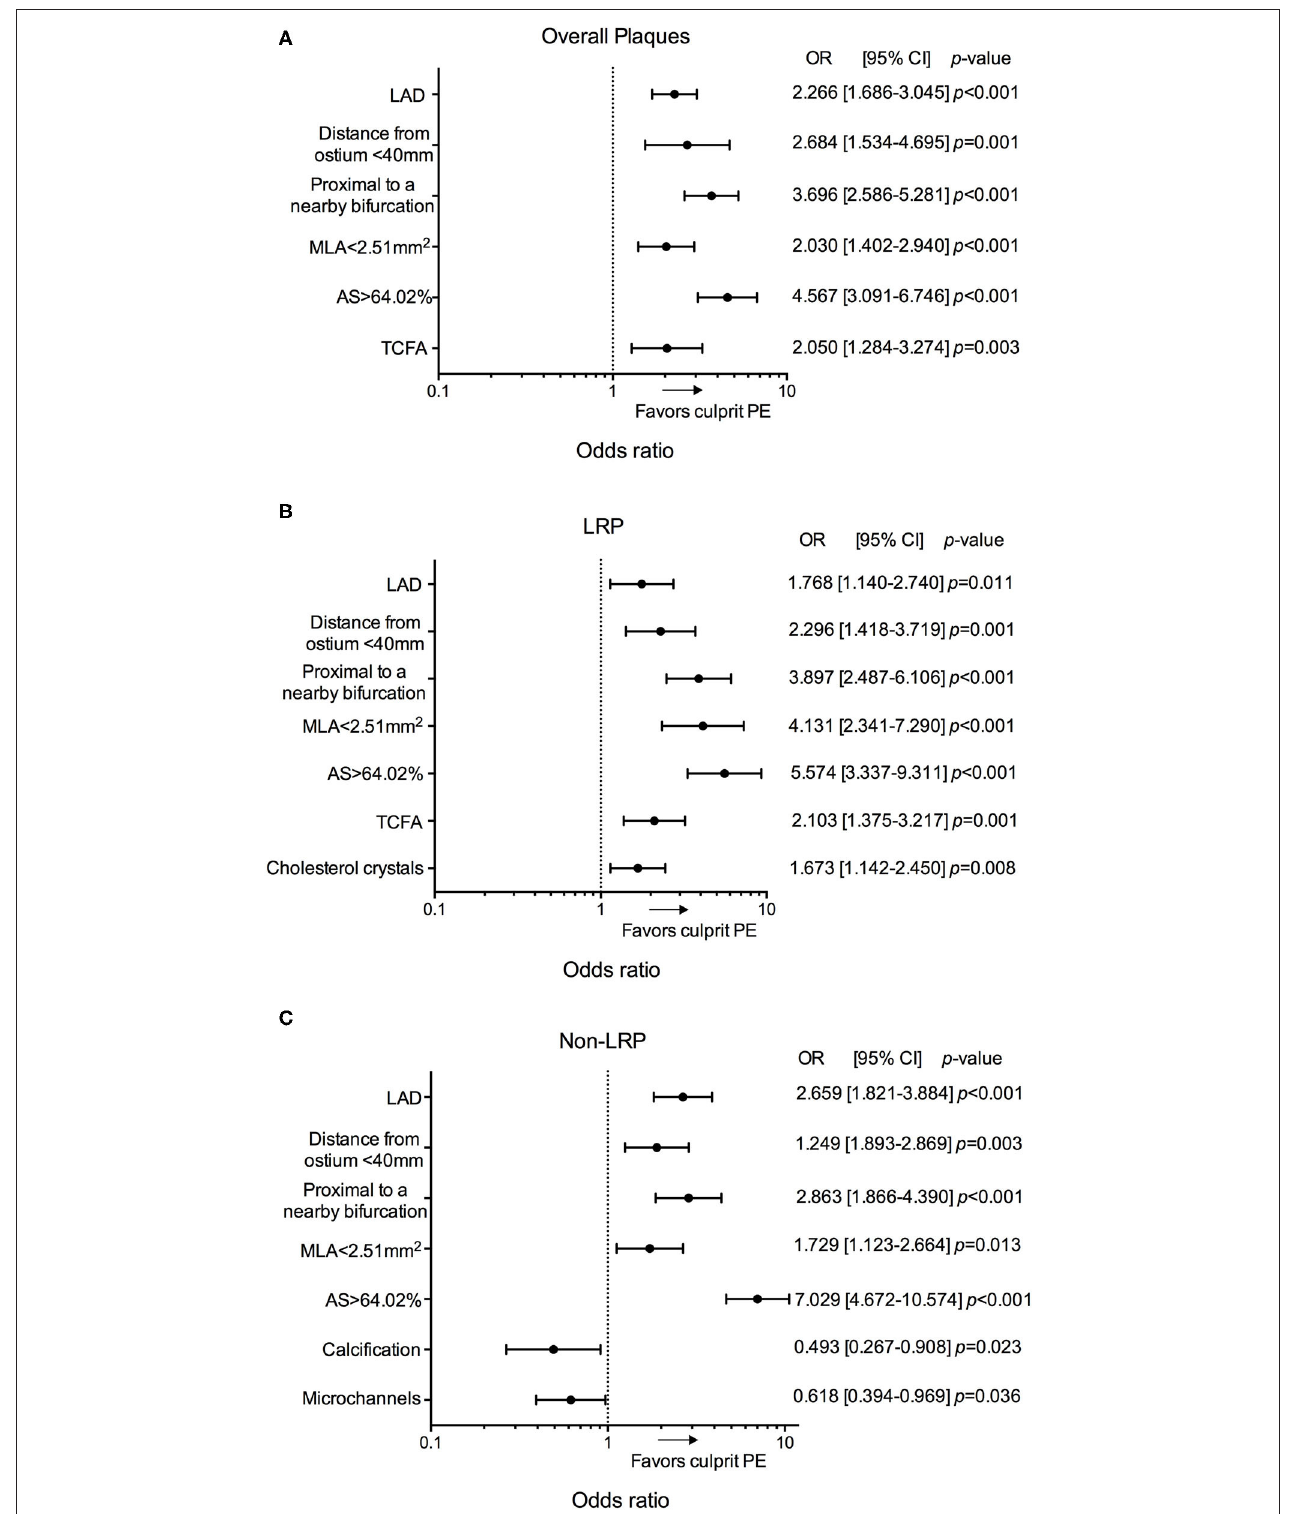
FIGURE 4 | Predictors for culprit PE in overall cohort of 484 patients. Odds ratios for the presence of culprit PE overall (A) , in LRPs (B) , and in non-LRPs (C) according to LAD location, distance from the coronary ostium < 40mm, proximal to a nearby bifurcation, MLA < 2.51 mm 2 , AS > 64.02%, TCFA, presence of cholesterol crystals, calcification and microchannels. AS, area stenosis; CI, confidence interval; LAD, left anterior descending artery; LRP, lipid-rich plaque; MLA, minimal lumen area; OR, odds ratio; PE, plaque erosion; TCFA, thin-cap fibroatheroma.